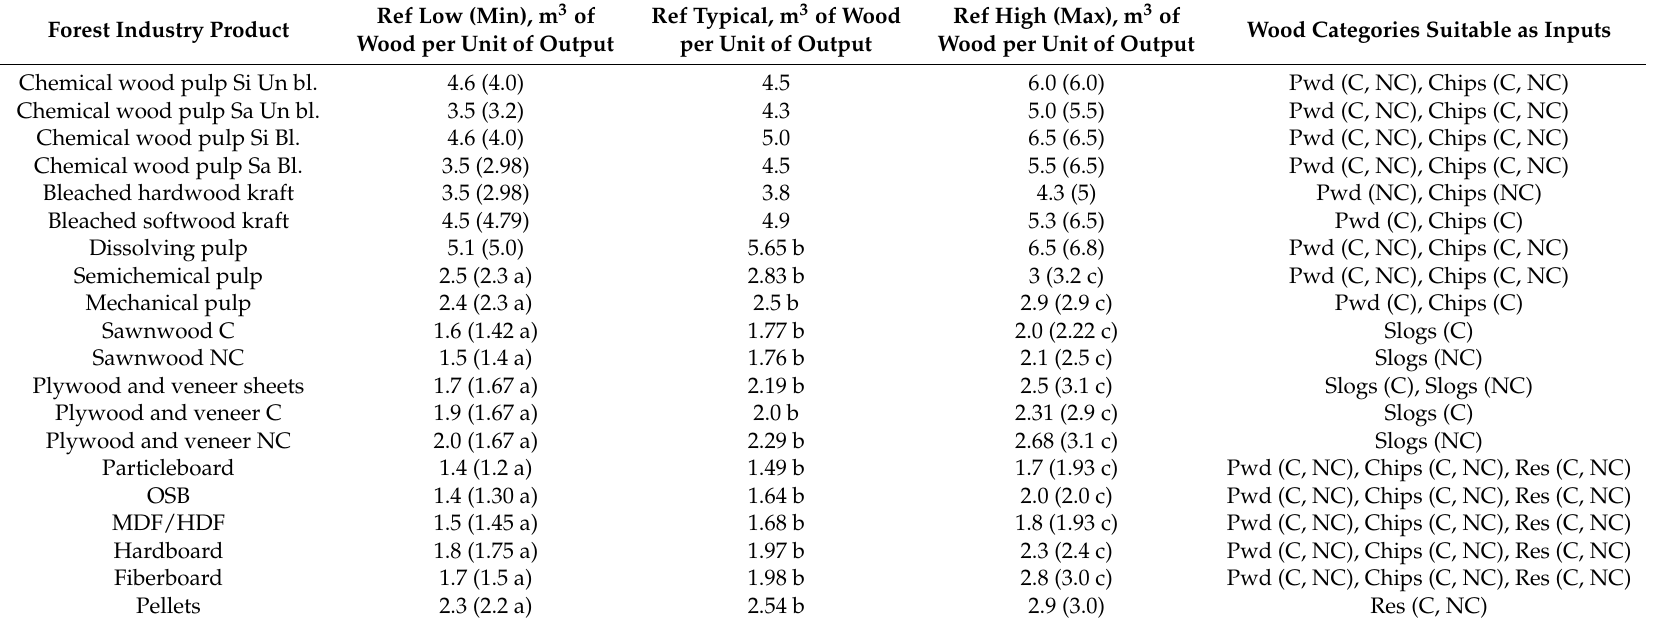
Table 2. Wood categories suitable as inputs in forest industry products and the assumed typical (Ref), low (Ref low), and high (Ref high) wood input quantities in the linear programming (LP) test when country-specific reference quantities were not available. Min and Max in the parentheses are additional broader minimum and maximum input quantities applied for all regions, respectively. Slogs = sawlogs and veneer logs, Pwd = pulpwood, Res = wood residues, Chips = chips and particles, C = coniferous, and NC = non-coniferous. Sources: a = The smallest value given in UNECE [18] (after Spain and Portugal with 1.2 m 3 /m 3 for veneer sheets removed from the sample); b = Average of all values in [18]; and c = the highest value in [18]. If data were not available from [18] for (a), (b), or (c), data from [16] were used. Ref Low (Min), m 3 Forest Industry Product